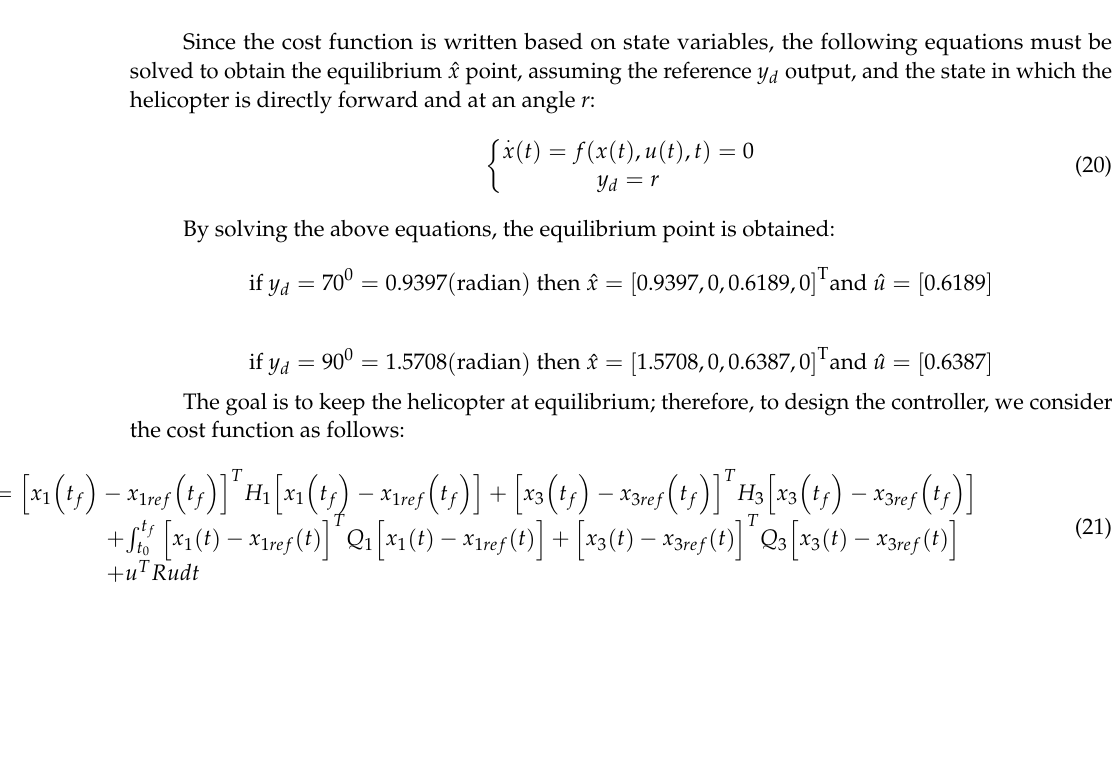
Table 1. State space parameters of the helicopter. a 1 = 0.1950 I = 0.0055 (N.m) T 1 = 0.3550 (N) b 1 = 0.0030 B ϕ = 0.0011 τ g =